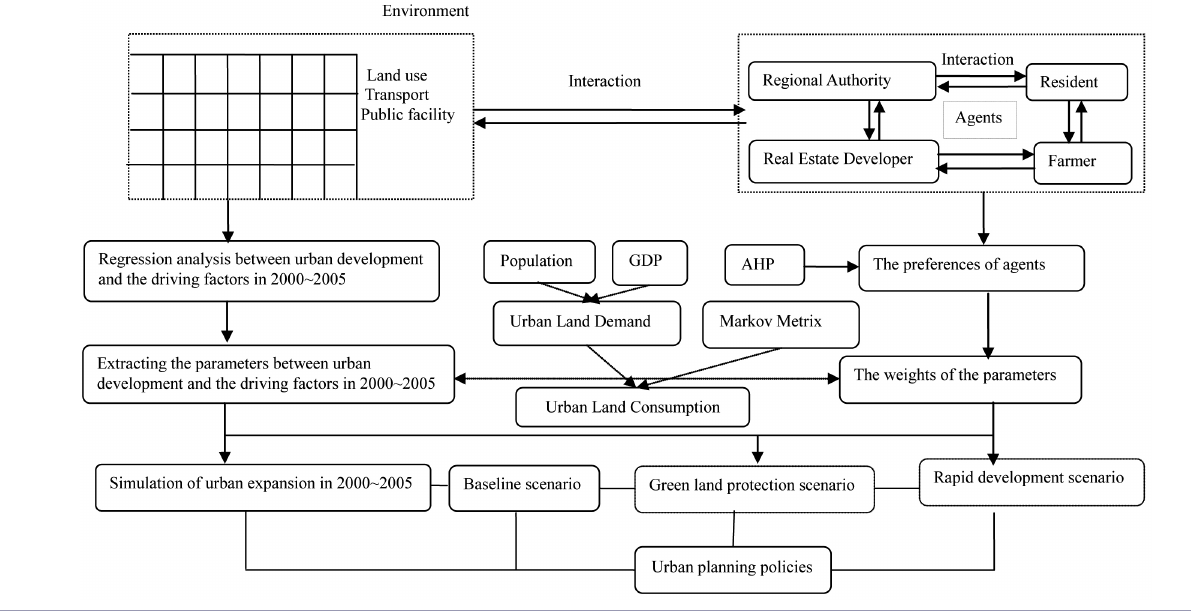
Fig. 2 . Agent-based model